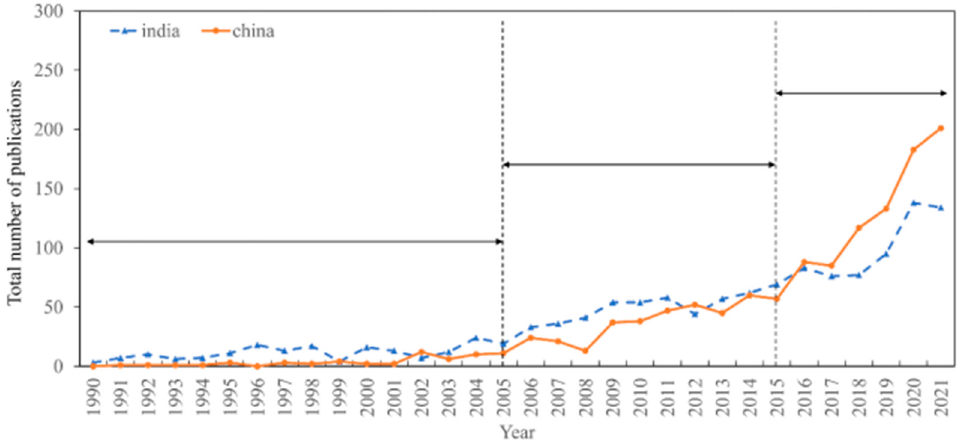
Figure 1. Annual trend in publications from 1990 to 2021.